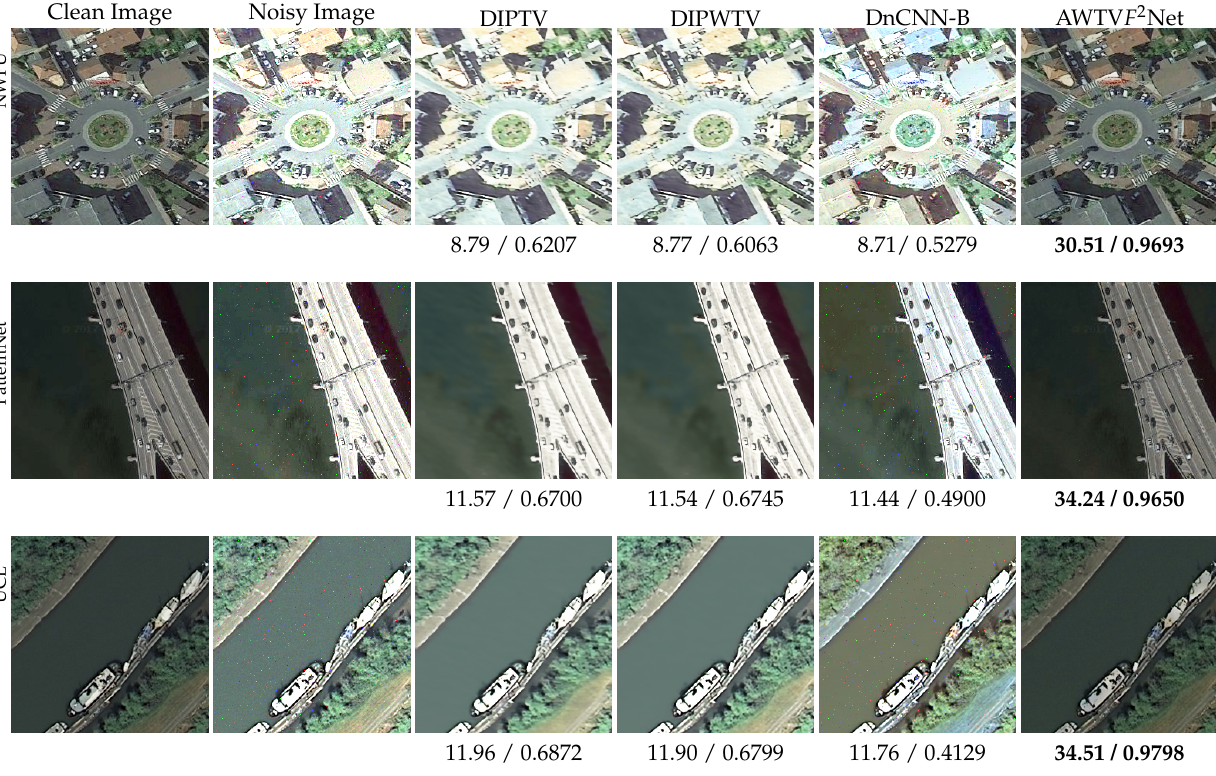
Figure 17. Restored results of images distorted by mixture noise of Salt&Pepper and Speckle. Although the DnCNN model had a competitive capability to remove noise, it caused color distortion and smoothed the details of images, as shown in Figure 16. For this case of noise, the DIPTV and DIPWTV models caused some water ripples in the restored